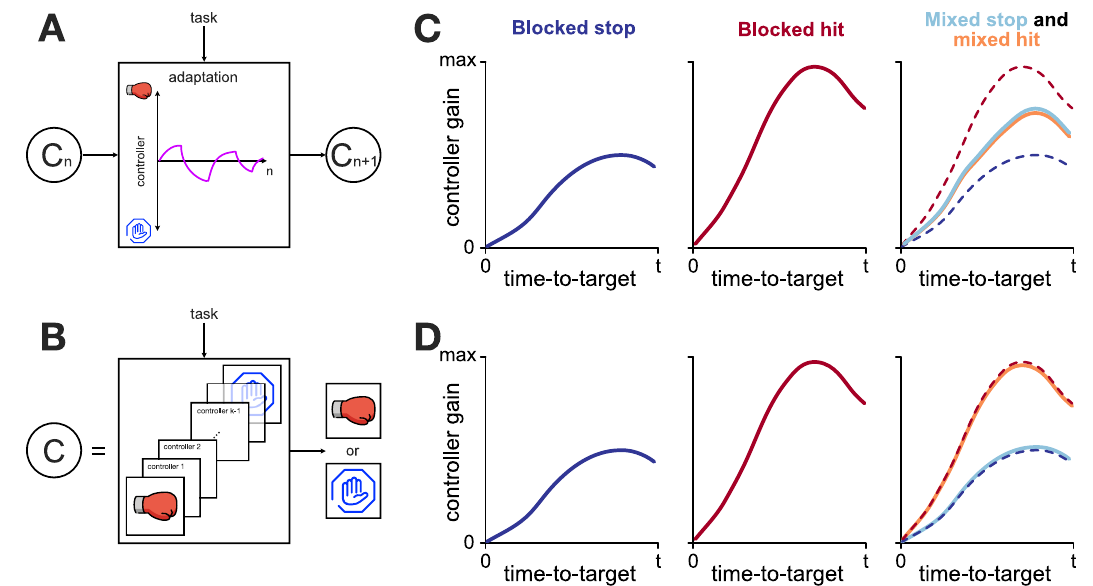
Fig 1. Theoretical predictions of two different architectures for feedback regulation. A . Universal feedback controller. A single feedback controller is used to produce both stop and hit movements, and is adapted to the given task over multiple trials. Such adaptive behaviour is reminiscent of the behaviour of the feedforward controller when learning two opposing force-fields without separable context. C n indicates a feedback controller at trial n B . A feedback controller as a set of task-specific controllers. A task- specific controller (stop or hit) is selected based on the task-related context and is used during the given movement. Such contextual switching behaviour is reminiscent of the behaviour of the feedforward controller when learning two opposing force fields with separable context. C . Expected regulation of feedback responses by the universal feedback controller. When exposed to a single task for a long time (blocked schedule) the controller adapts to the given task, producing optimal responses for both stop and hit conditions. However, due to interference within the mixed schedule, such a controller would settle to the average (or weighted average) gains between the two blocked conditions. D . Expected regulation of feedback responses by a set of task specific controllers. Within the blocked schedule, similar regulation is expected between hit and stop as in the case of the universal controller ( C ). However, in the mixed schedule, due to the task-related context, an appropriate controller is recalled on a trial-to-trial basis, producing similar regulation as within the blocked schedule.